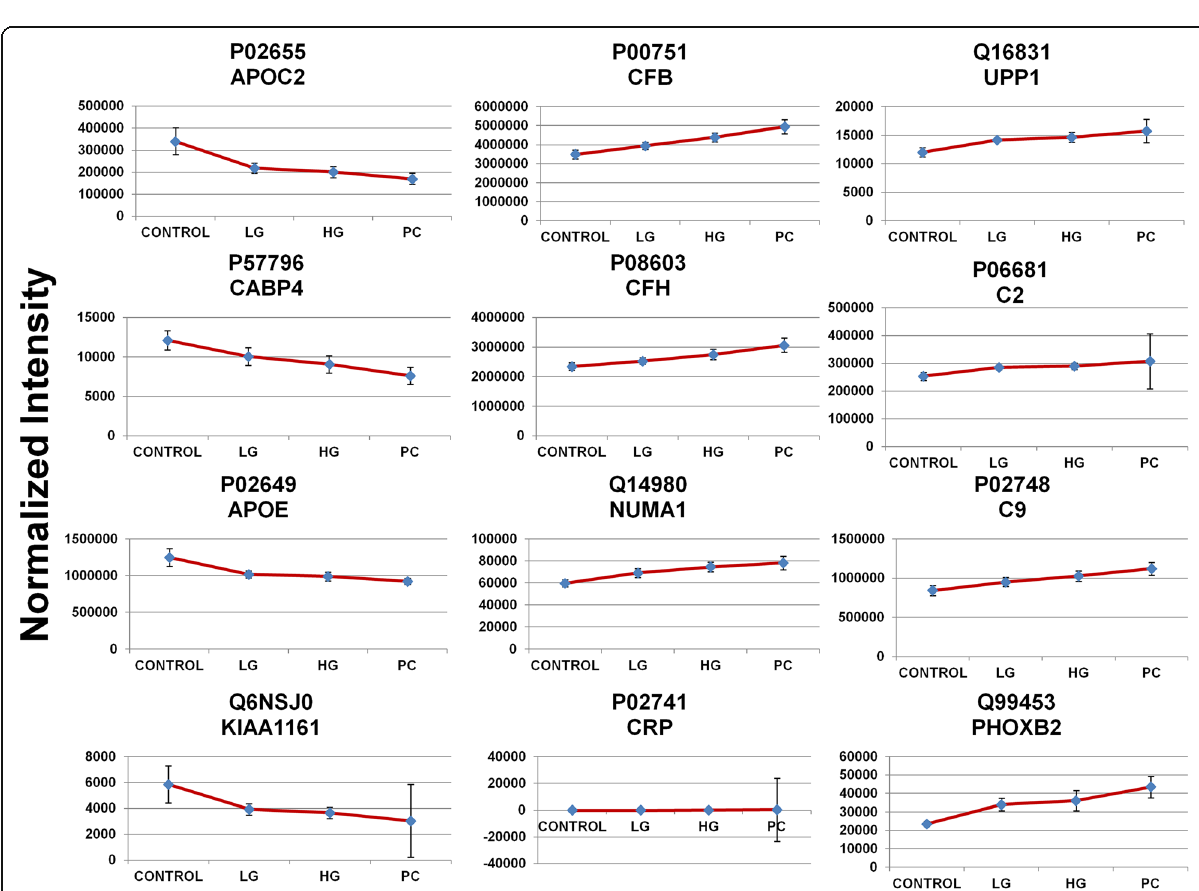
Fig. 3 The line graphs of all the protein in the dataset were made by taking means (±SEM) of every group. Proteins having a clear trend of consistently decreasing or increasing values from controls to Low-grade dysplasia (LG) to High-grade dysplasia (HG) to Pancreatic carcinoma (PC) are shown here. The first column has proteins which are decreasing from healthy controls to pancreatic carcinoma and other 2 columns have proteins which are increasing from healthy controls to pancreatic carcinoma. These proteins were later confirmed to have statistically significant trend by Mann Kendall